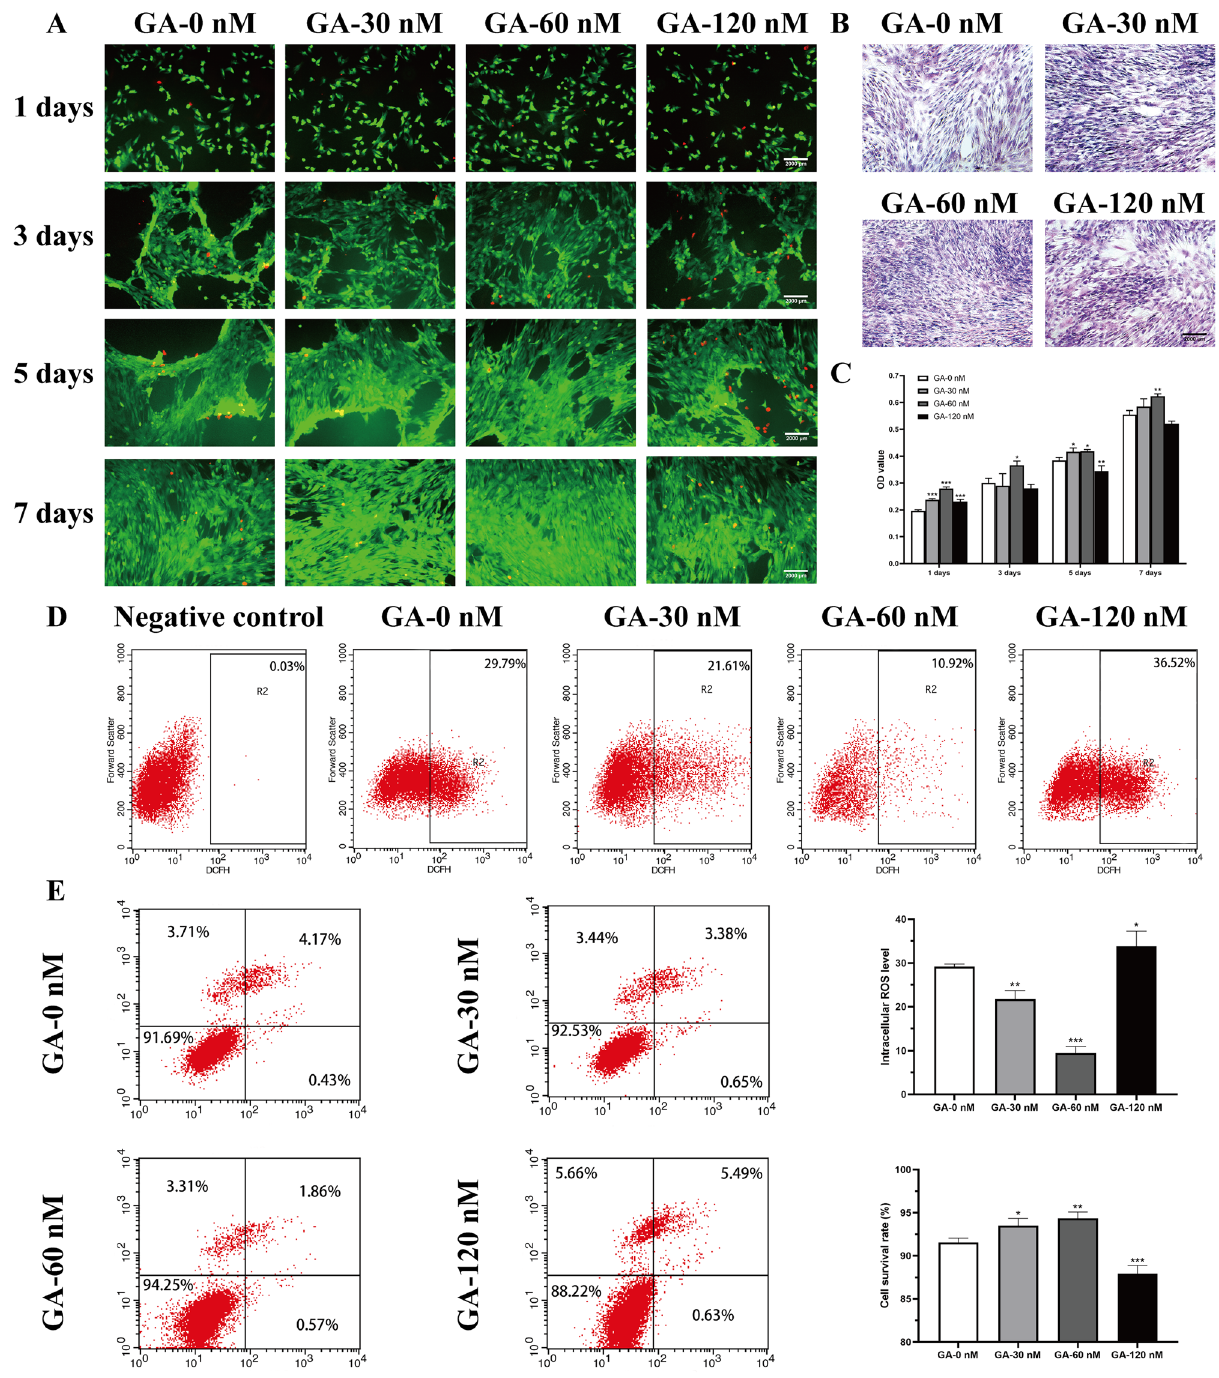
Figure 2. Promotion effects of His6-GABARAP on normal BMSCs. MTT assay (C) and FDA/PI staining (A) were applied to detect the cytotoxicity and viability of His6-GABARAP at days 1, 3, 5, and 7. Cells were treated with various concentrations of His6-GABARAP for 7 days. (B) H&E stained for cell morphology. (D) Flow cytometry for intracellular ROS. (E) Quantitative flow cytometry for viability. GA-0 nM (without His6-GABARAP); GA-30 nM (with 30 nM His6-GABARAP); GA-60 nM (with 60 nM His6-GABARAP); GA-120 nM (with 120 nM His6-GABARAP). Values are the means ± SD, n = 3. *p < 0.05, **p < 0.01, ***p < 0.001 relative to the normal group. Scale bar, 2000